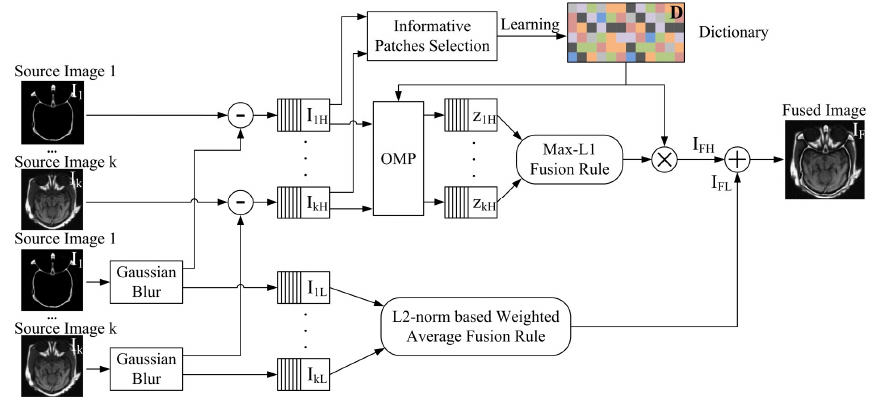
Figure 1. The Proposed Image Fusion